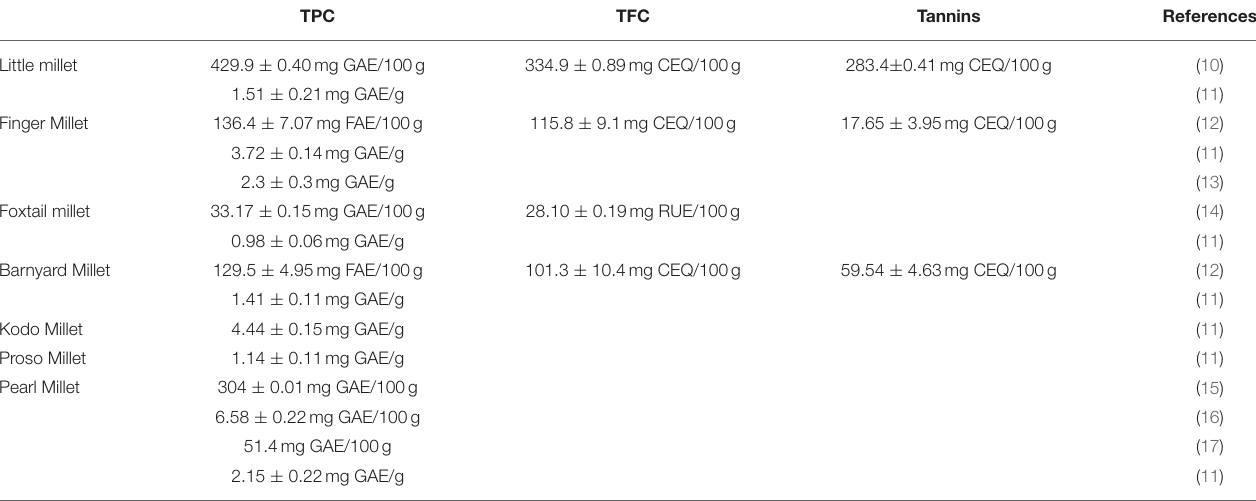
TABLE 1 | The total polyphenol content (TPC), the total flavonoids content (TFC) and Tannins in different varieties of